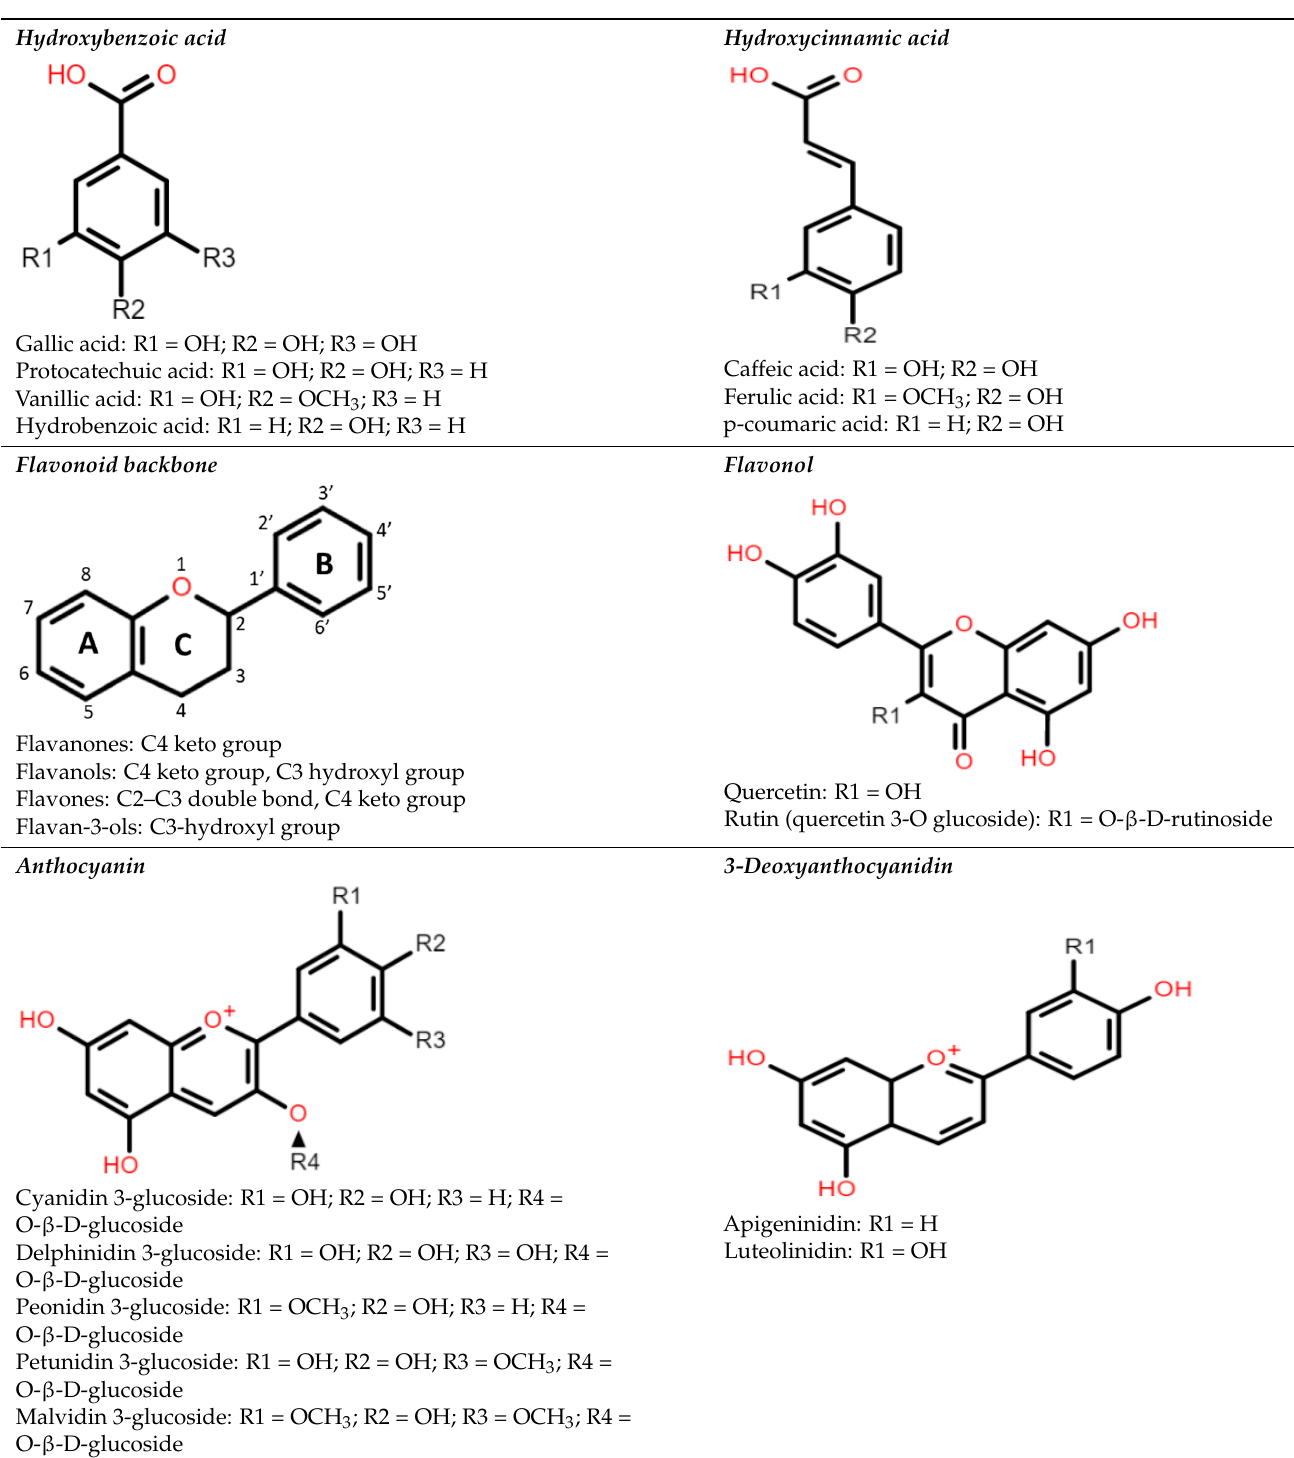
Table 1. Basic structures of common phenolic compounds found in cereals.